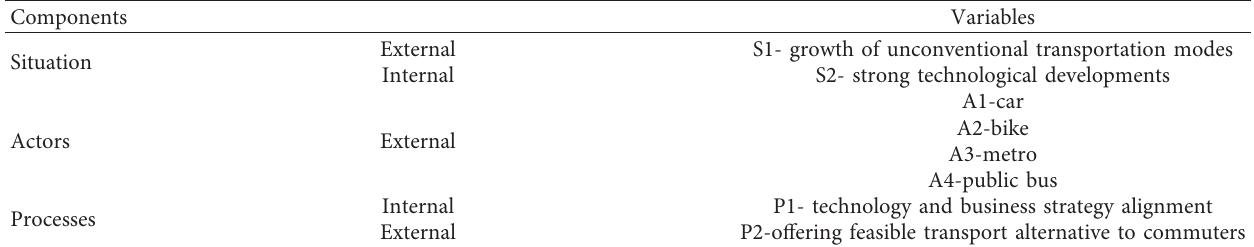
Table 9: Variables of SAP-LAP in the context of choosing a suitable vehicle mode.